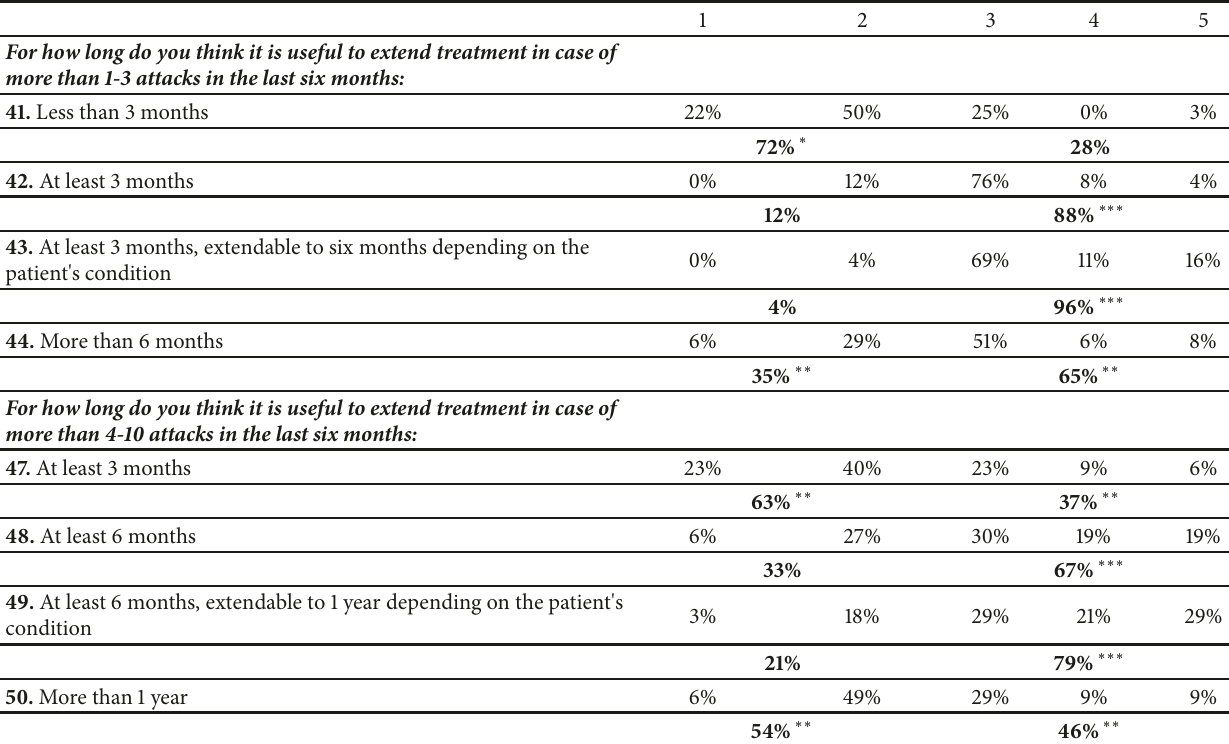
Table 4: Results of theConsensus Conferenceon betahistinetreatmentduration.1 = absolutely disagree, 2= disagree, 3= agree,4= more than agree, and 5 = absolutely agree. Consensus was reached when the sum of items 1 and 2 or 3, 4, and 5 reached 66%. Same asterisk convention.